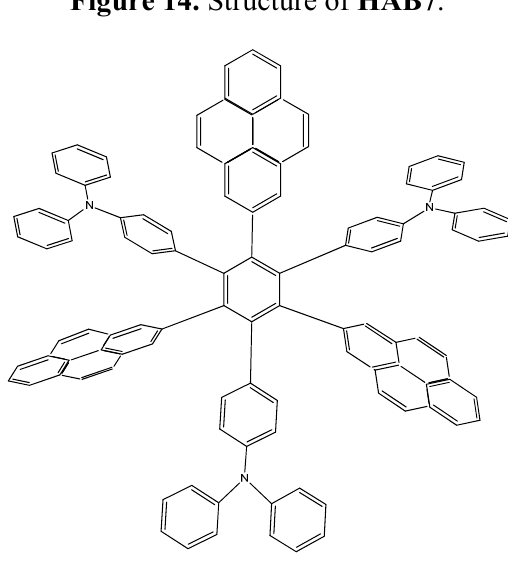
Figure 14. Structure of HAB7